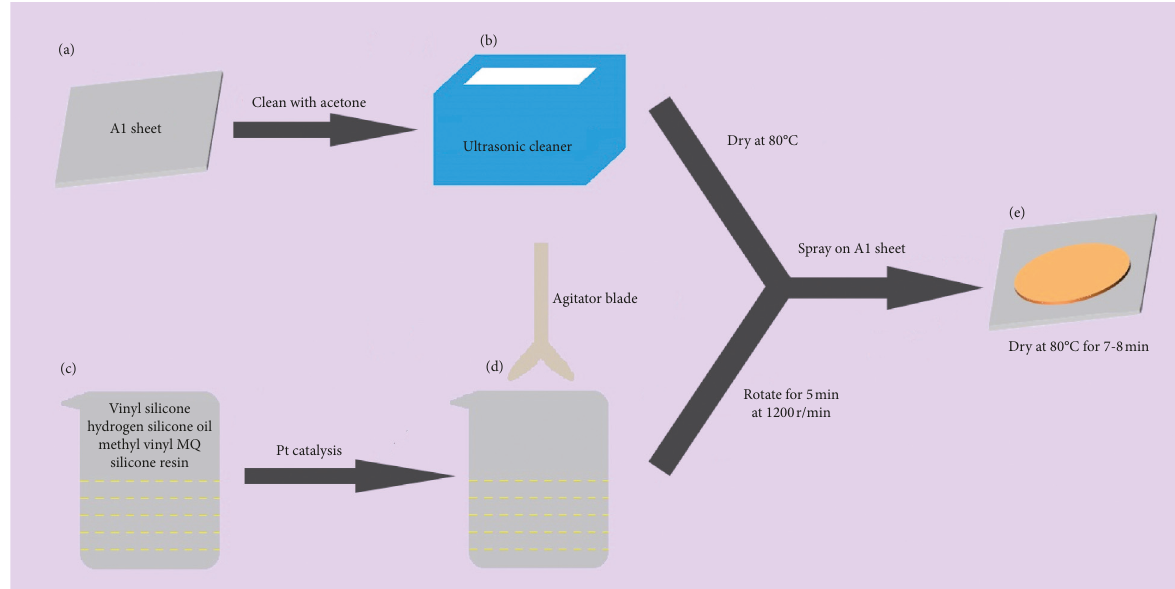
Figure 2: Preparation process of antisticking silicone rubber: (a, b) the cleaning and drying process for the Al sheet, (c, d) mixing of components, and (e) the curing process of coating sprayed on Al Table 1: Mass ratio of methyl vinyl MQ silicone resin samples. Samples no.